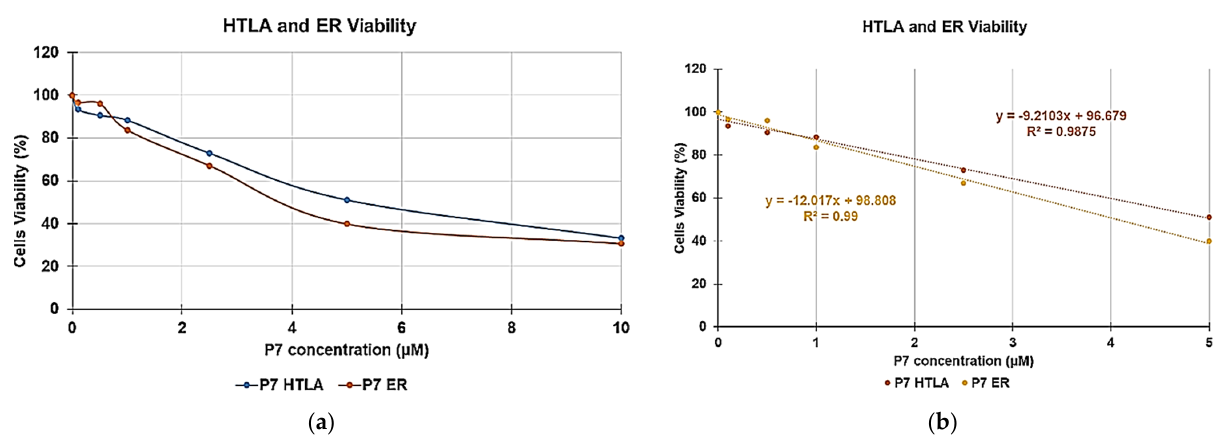
Figure 8. Dispersion graphs of the viability of HTLA-230 (HTLA) and HTLA-ER (ER) cells exposed to increasing concentra- tion of P7 (0–10 µ M) for 24 h ( a ); linear regressions associated with the dispersion graphs of the viability up to 5 µ M for both NB cells populations ( b